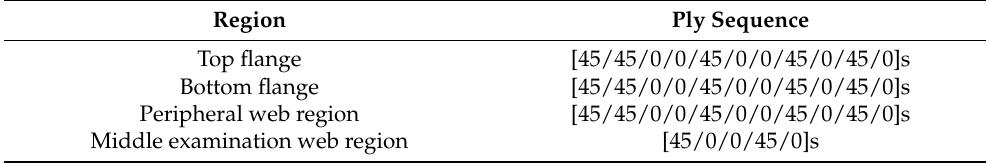
Table 2. Ply sequences of the different regions for the BW-I composite beams.